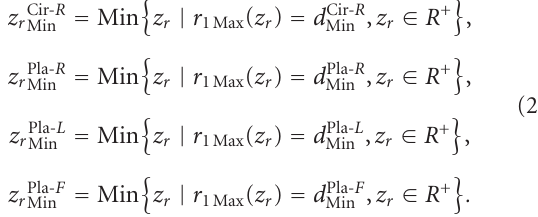
Figure 7: Comparisons between measurement and theory on the propagation mechanisms and their dividing point in the near- region inside an arched